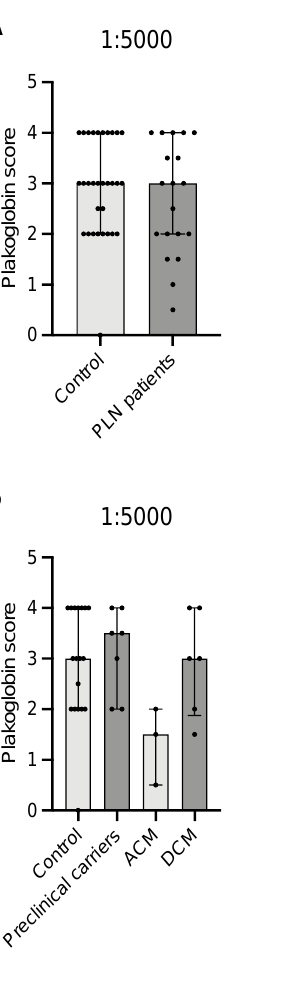
Figure 7. ( A ) No significant differences at the population level between healthy controls ( n = 34) and PLN carriers ( n = 17) in any of the dilutions. ( B ) Graphs depict differences in plakoglobin score between controls ( n = 34), PLN variant carriers that are preclinical ( n = 7), with an ACM ( n = 3) or DCM ( n = 7) phenotype. ACM PLN patients seem to adhere more to the ACM patients’ pattern of plakoglobin score. PLN; phospholamban, ACM; arrhythmogenic cardiomyopathy, DCM; dilated cardiomyopathy. • indicate individual(s) for the